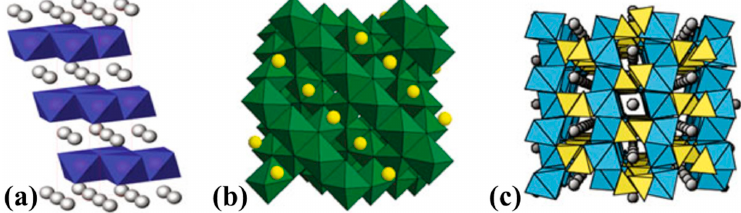
Figure 8. The structure of the ( a ) layered oxide LiCoO 2 ; ( b ) spinel LiMn 2 O 4 ; and ( c ) olivine LiFePO 4 . Adapted with permission from [33], © Springer, 2013.